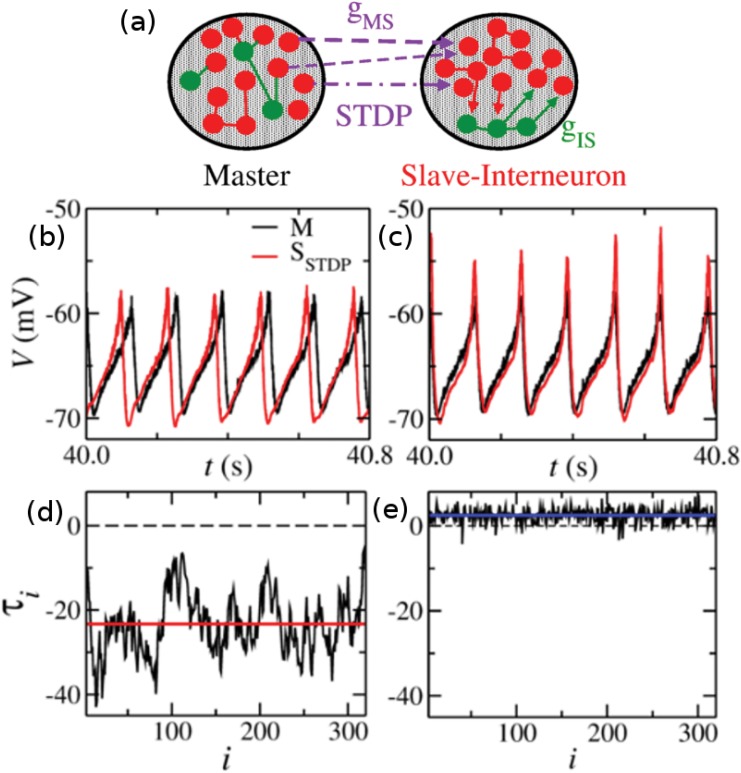
The interplay between phase difference and STDP in neuronal populations.(a) Master and Slave-Interneuron cortical-like populations. Each synaptic weight g
MS (from Master to the Slave) is subject to STDP rules. (b)-(c) Membrane potentials of M (black) and S (red) populations in the AS regime (b) and in the DS regime (c) in the presence of plasticity. (d)-(e) The time delay in each cycle τ
i. The mean time delay τ (flat line) is negative in the AS regime (d) and positive in the DS regime (e). The AS and DS regimes are obtained modifying only one parameter in the model. The inhibitory conductances in the Slave-Interneuron population is set to g
IS = 4 nS in the AS regime (b) and (d), whereas g
IS = 16 nS in the DS regime (c) and (e).